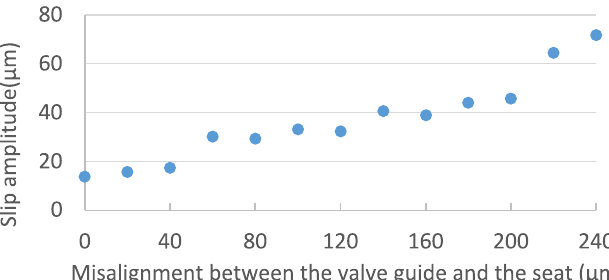
Fig. 11. Amplitude of movement of the valve when sliding against the seat as a function of the misalignment existing between the seat and the valve guide (speed of 600